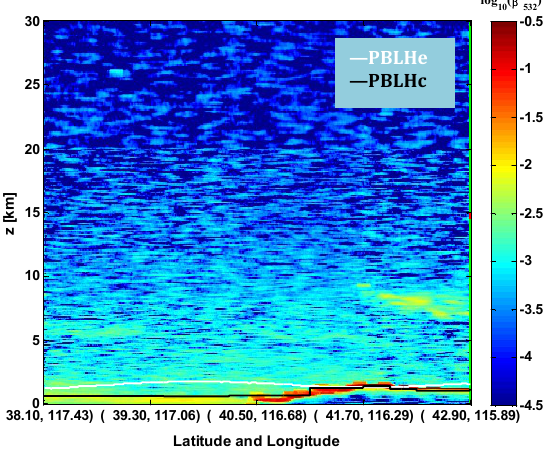
Figure 12. CALIPSO backscattering distribution and PBLH of the Beijing area on February 13, 2015.